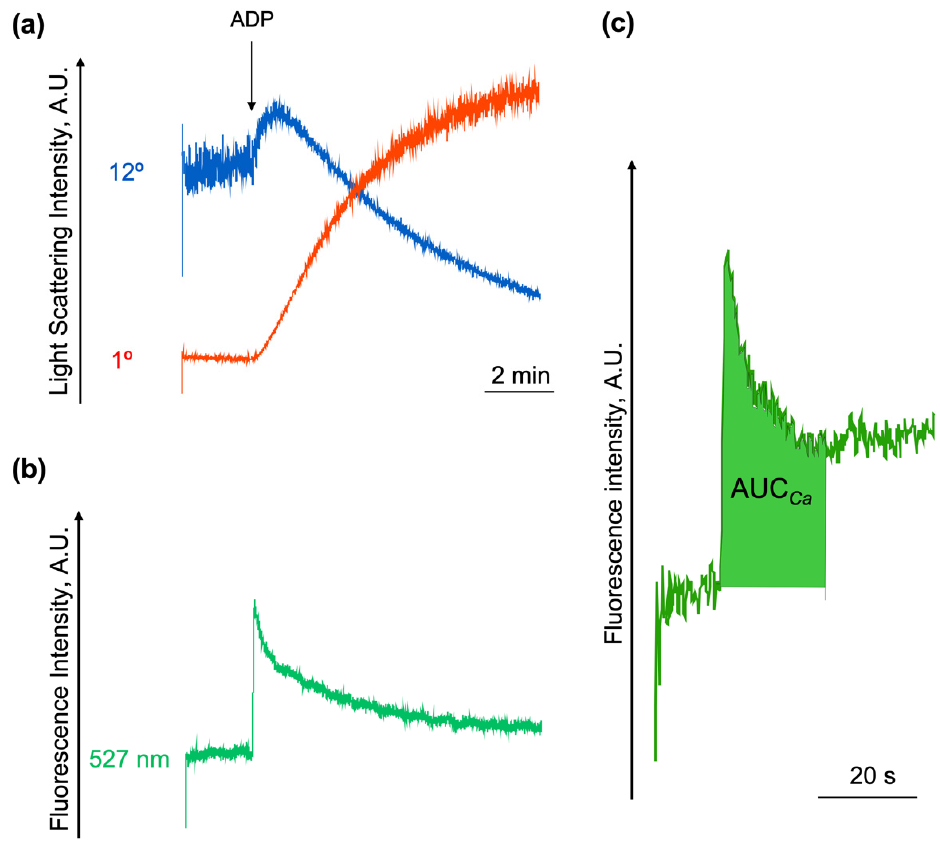
Figure 3. Simultaneous registration of platelet transformation and changes in [Ca 2+ ] i . PRP was loaded with Fluo-3 AM (5 µ M), then diluted in HEPES buffer (1 × 10 7 platelets/mL) and added to the cuvette with continuous stirring (1200 rpm) at 25 ◦ C. After the registration of the basal signal (3 min), ADP (800 nM) was added to the platelet suspension. ( a ) The platelet shape change reaction and aggregation were monitored as in Figures 1 and 2 according to the changes of LSI signal measured at 12 ◦ and 1 ◦ , correspondingly, and ( b ) [Ca 2+ ] i signal was detected at FL1 channel; ( c ) to characterize ADP-induced [Ca 2+ ] i changes in dynamics, the AUC Ca within the first 20 s after the application of ADP was calculated. Raw traces from the LaSca laser analyzer, shown are the data from one experiment out of four.